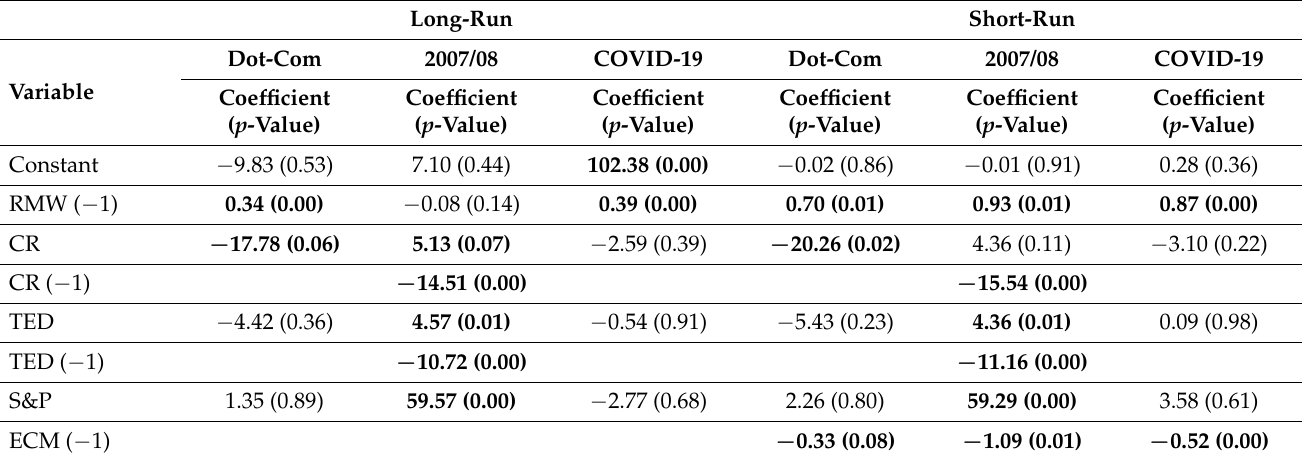
Table 21. Long-run ARDL model and short-run error correction model for RMW (Recession). Long-Run